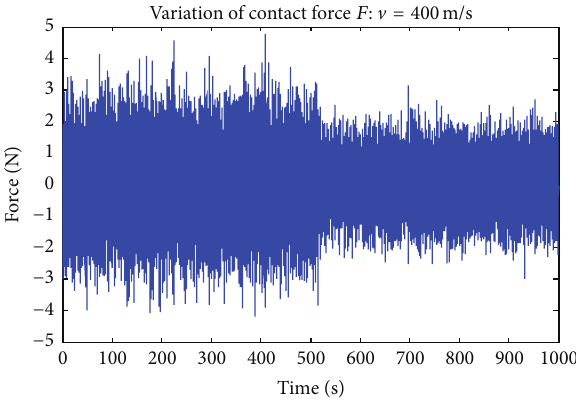
Figure 7: The reduction of variation in contact force 𝐹 for V = 400 m /